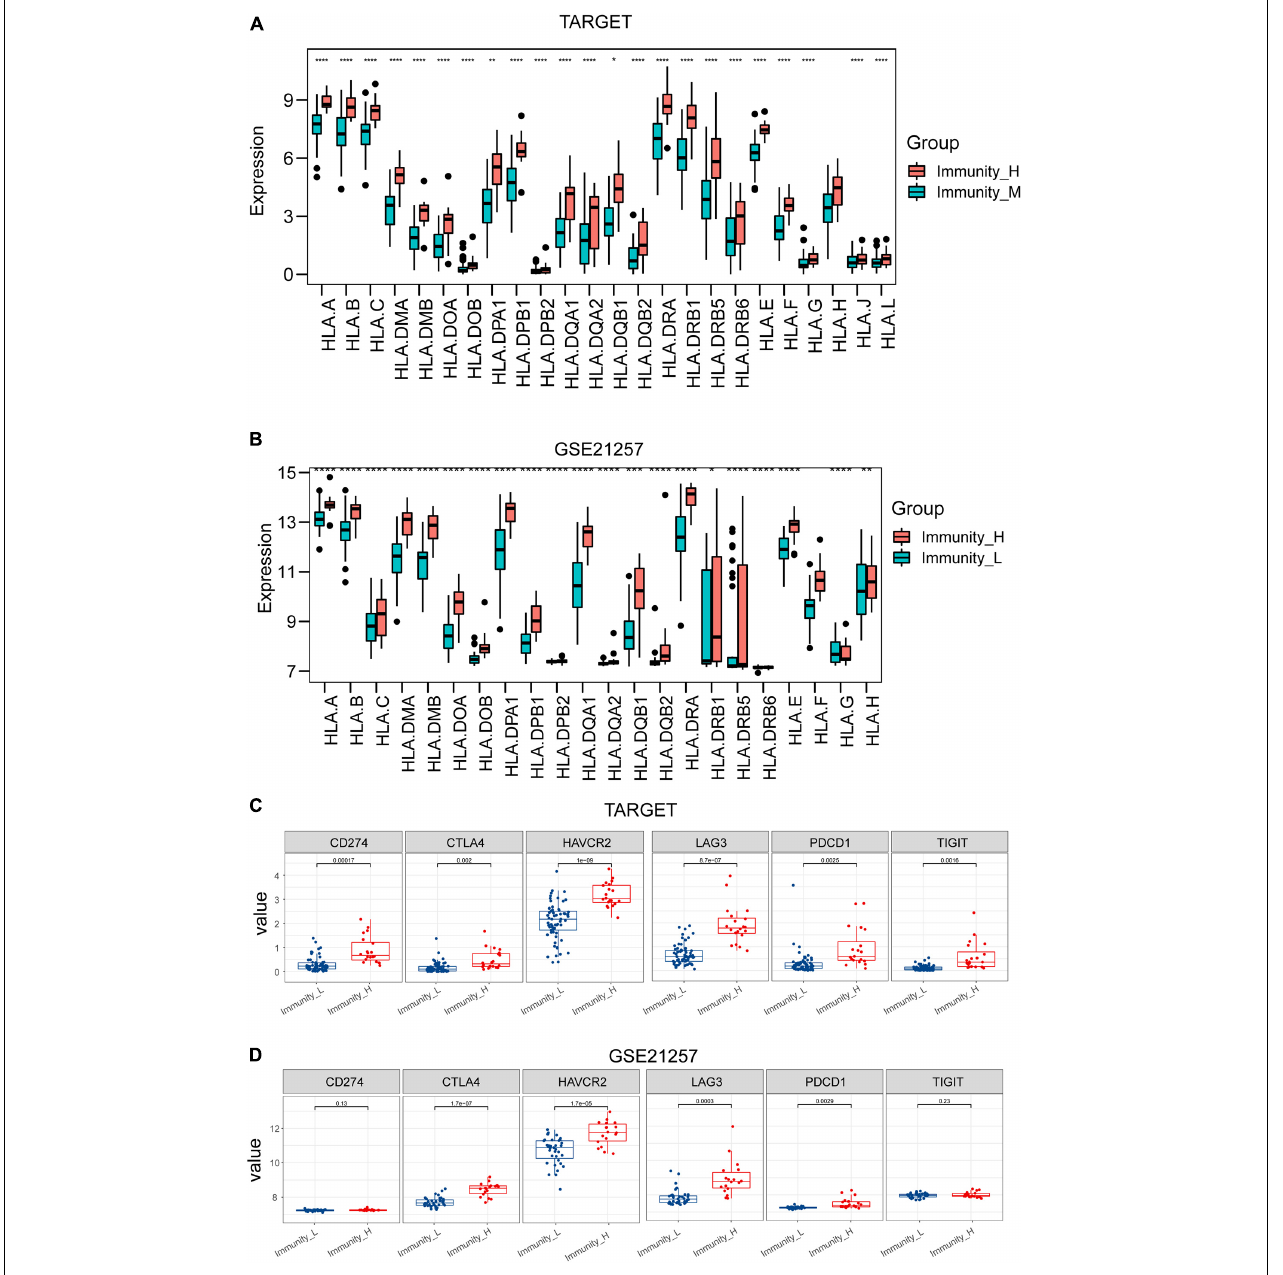
FIGURE 3 | Box plots presented differential expression of HLA genes (A,B) and multiple immune checkpoints (C,D) between Immune_H and Immune_L subtypes. ** p < 0.01, *** p < 0.001, and **** p <